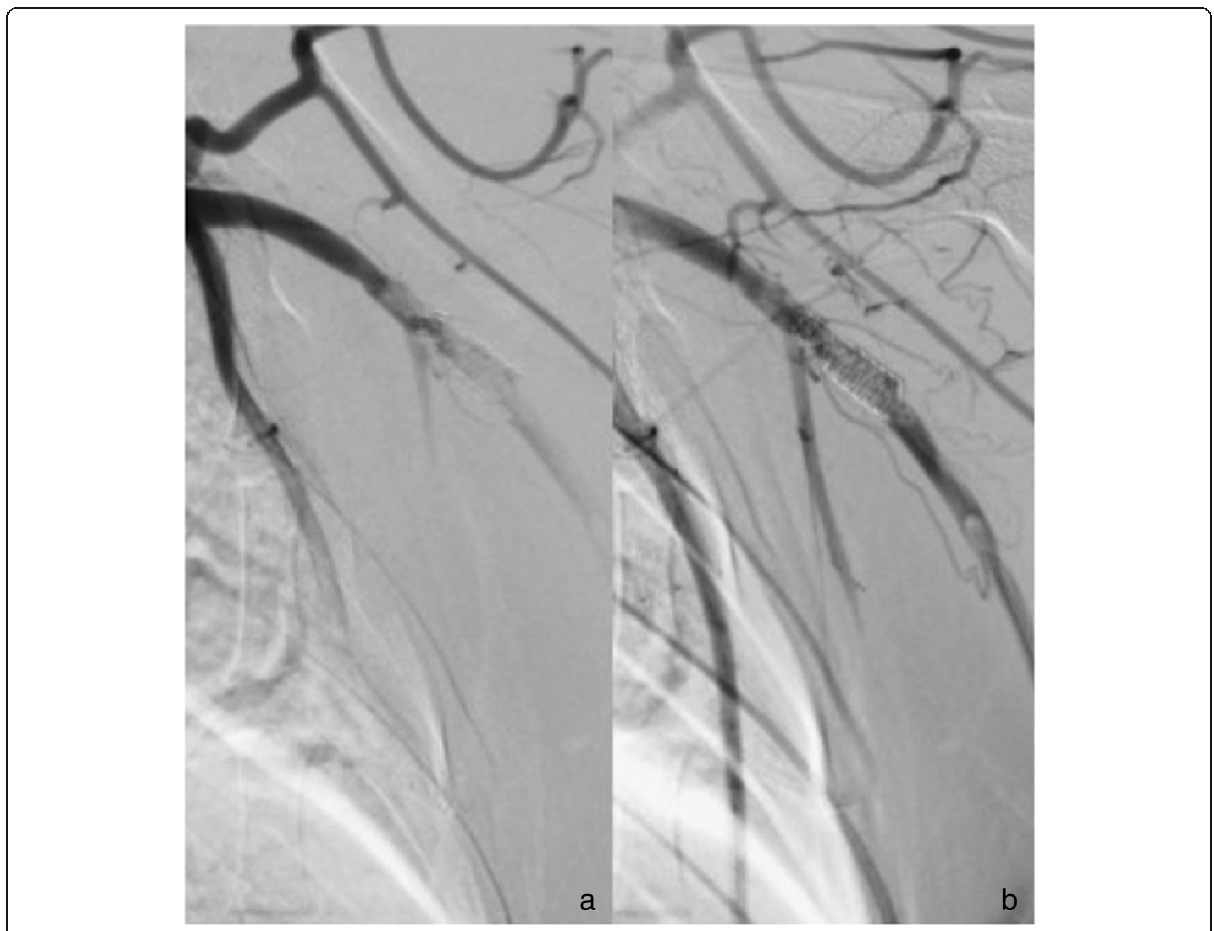
Fig. 5 Unsubtracted angiographic series of the left subclavian artery of subject number 3 (treated with ASA only), implanted with an uncoated p64 stent, at day 28 (final angiographic control). It shows the occlusion of the stent lumen by moderate in-stent thrombosis ( a ) with subsequent impairment of the distal arterial flow ( b )